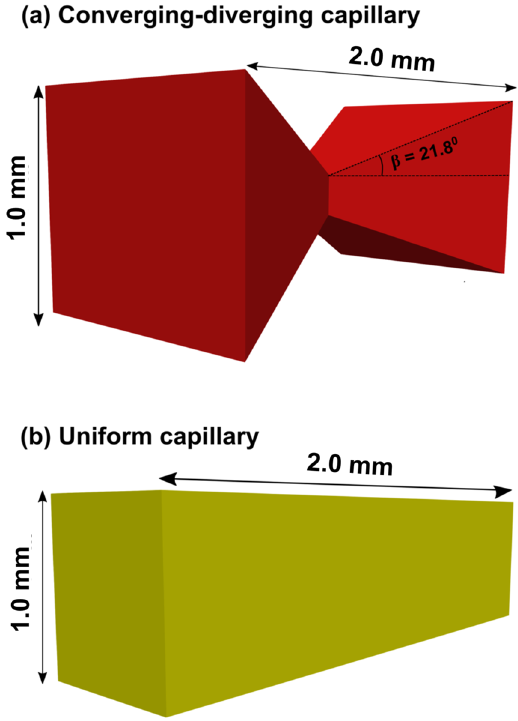
Figure 1. 3D representation of the capillaries used in the numerical simulations. ( a ) Converging-diverging geometry. ( b ) Uniform square